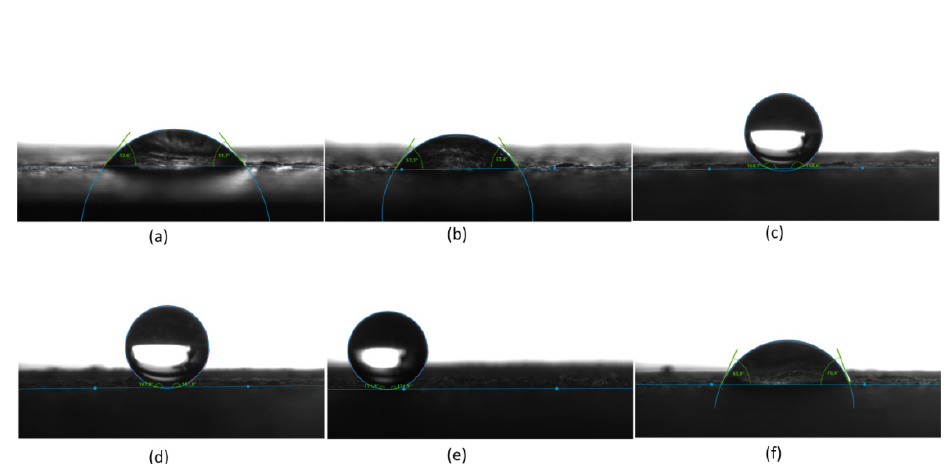
Figure 10. Water contact angle on di ff erent surfaces. ( a ) uncoated wood beech; ( b ) polyester thick film; ( c ) TiO 2 film; ( d ) polyester / TiO 2 thick film; ( e ) polyester / TiO 2 thin film; ( f ) polyester / TiO 2 film via (PSP). Table 6. Average water contact angle values for the beech wood surfaces before and after the abrasion test. Contact Angle ( ◦ ) before Samples Contact Angle ( ◦ ) after Abrasion Abrasion Uncoated wood 45 ± 3 - Polyester thick film 55 ± 2 73 ± 3 TiO 2 film Polyester / TiO 2 thick